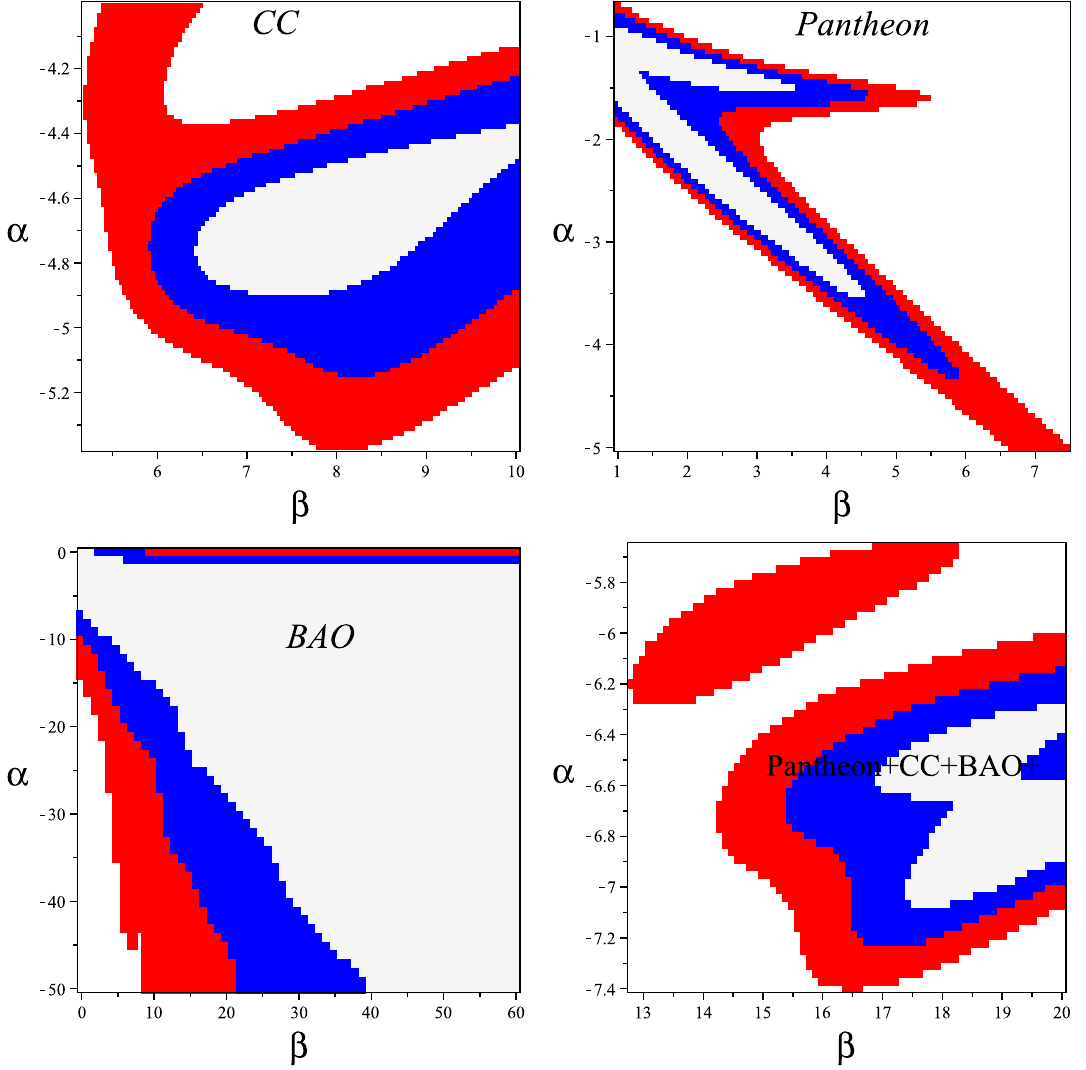
Fig. 1 The constraints at the 68 . 3%, 95 . 4% and 99 . 7% confidence levels for parameters (α,β) ,from H ( z ) (CC), Pantheon, BAO and combination, Pantheon +CC+ BAO